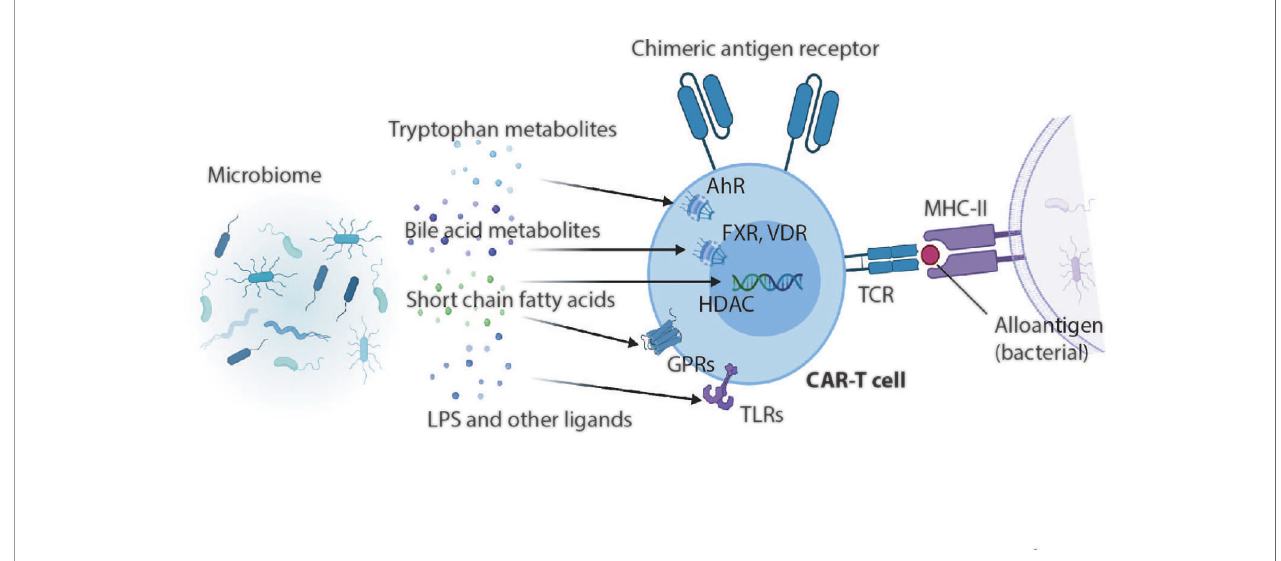
FIGURE 1 | Gut microbial metabolites and microbial ligands can exert far reaching in fl uences on T cells and presumably also CAR-T cells. Whereas tryptophan metabolites can act on T cells through the cytoplasmatic aryl hydrocarbon receptor (AhR), bile acid metabolites induce T cell differentiation and change effector functions through actions on vitamin D receptors (VDR), Farnesoid X receptor (FXR), and also through TGR5, PXR or LXR (no shown in this illustration). Short chain fatty acids act on T cells through G-protein coupled receptors 41, 43 or 109 (GPRs), or regulate immune cell differentiation and function through histone deacetylases (HDACs). Bacterial derived membrane fractions or secreted proteins modulate T cells via Toll-like receptors (TLRs) expressed on activated T